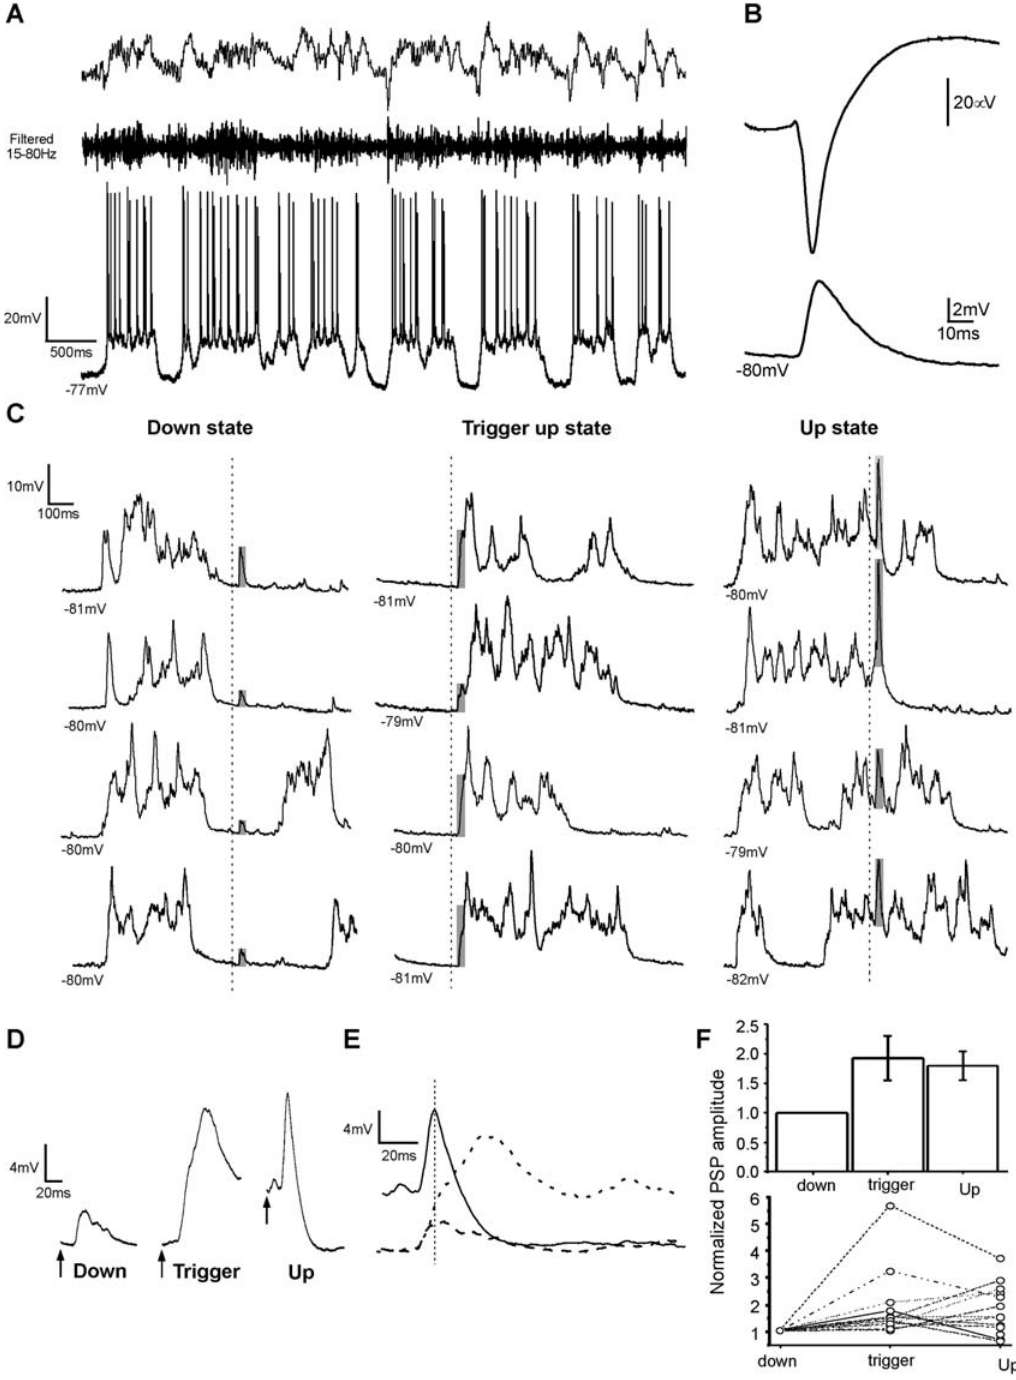
Figure 6. Whisker evoked synaptic potentials in up versusdown states in the cortexinvivo.A. Top trace. Extracellular, unfiltered, recording in the vicinity of the intracellularly recorded neuron in the barrel cortex of the rat. Middle trace. Filtered trace (15–80 Hz) to better illustrate the ocurrence of up states. Bottom trace, intracellular recording of a neuron during slow rhythmic activity. B. Whisker stimulation evoked response. Top, extracellular recording. Bottom, simultaneous intracellular recording. Each response is the average of 20 stimuli. C. Raw traces showing the PSP evoked by a puff of air in three different periods with respect to the occurrence to the up state: during down states (traces to the left), when PSP triggered an up state (middle traces) and when the PSP is evoked during an up state (traces to the right). D. In the same cell, the result of averaging 20 PSPs in each of the three cases shown in B. E. The same averages as in D but overlapped. The discontinous line illustrates where the amplitude measurements were taken, which is at the peak of the PSPs occurring during up and down states. F. Top, bar diagram of the normalized PSP values averaged for 13 neurons. Bottom, normalized values for each of the 12 neurons (an outlier was not represented).